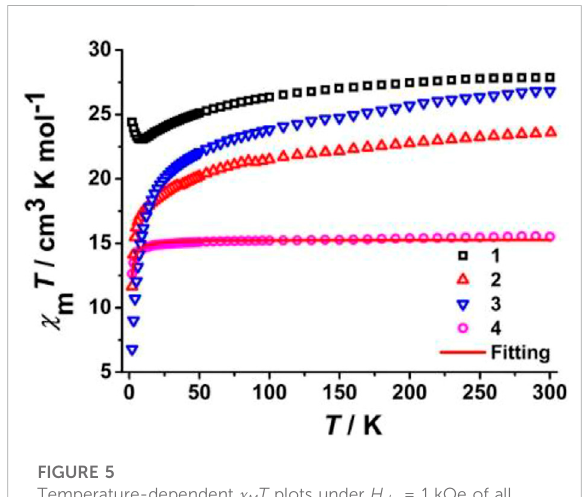
FIGURE 5 Temperature-dependent χ M T plots under H dc = 1 kOe of all prepared complexes. The red curve is the fi tting result of the experimental χ M T products of 4